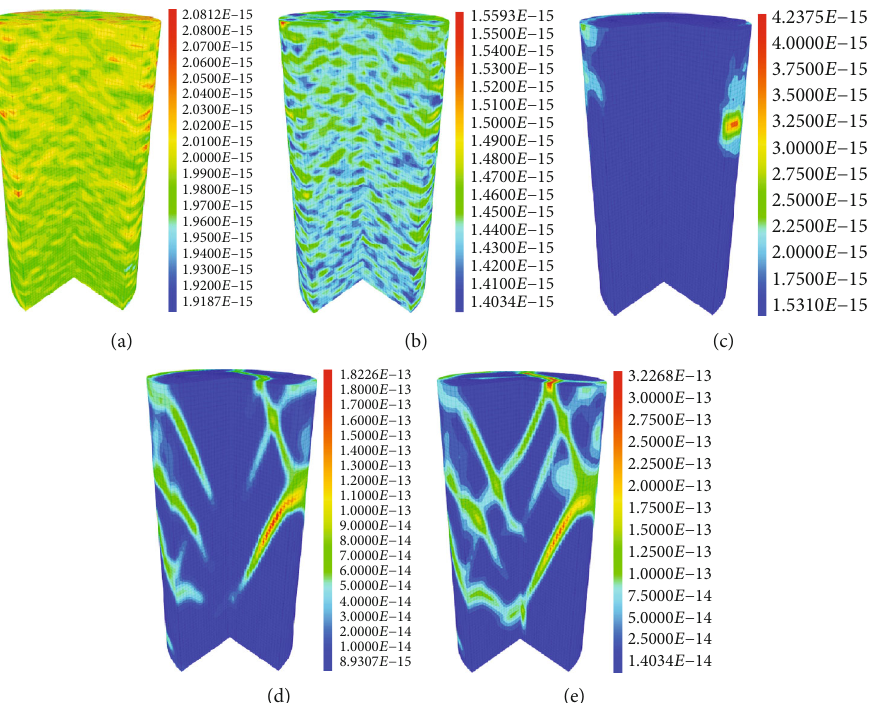
Figure 14: Evolution of permeability ( 10 − 3 m 2 ) for simulated HM coupled test: (a) initial compressed stage, (b) elastic stage, (c) peak stress point, (d) stress drop stage, and (e) residual stage.